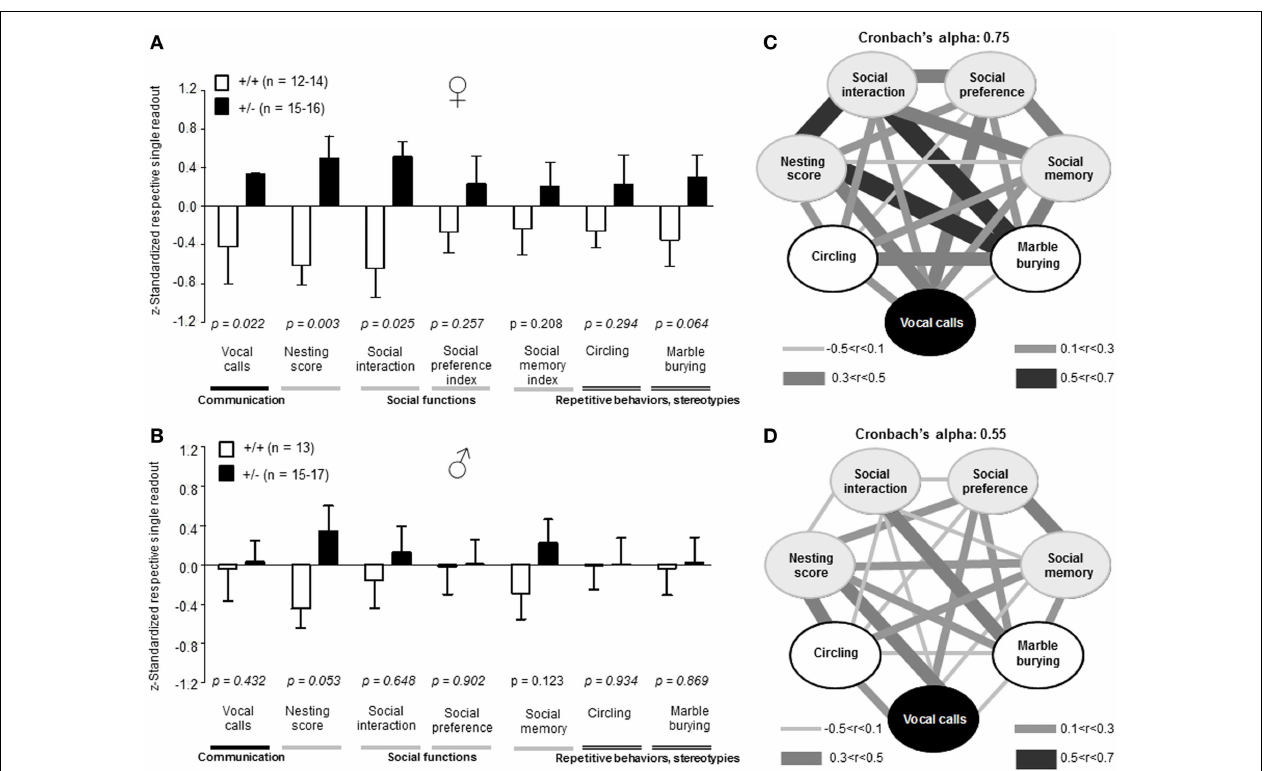
integrated into the composite score; mean ± SEM presented; respective sample sizes are indicated in the figures. (C,D) Intercorrelation pattern of the autism-relevant readouts including Cronbach’s alpha as a quality measure for internal consistency of the autism severity composite score.